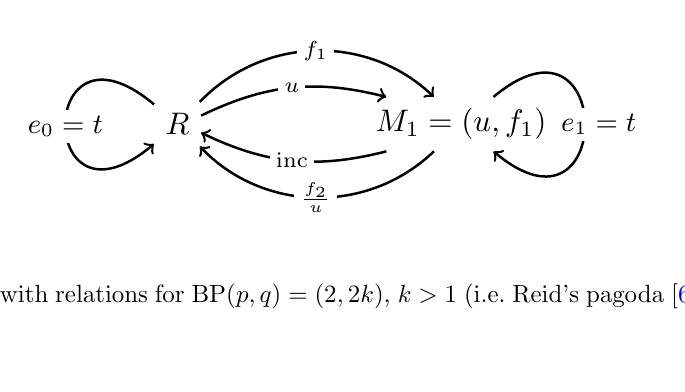
Figure 3. Quiver with relations for BP( p; q ) = (2 ; 2 k ), k > 1 (i.e. Reid’s pagoda [61]). f f 2 = z (cid:0) it k